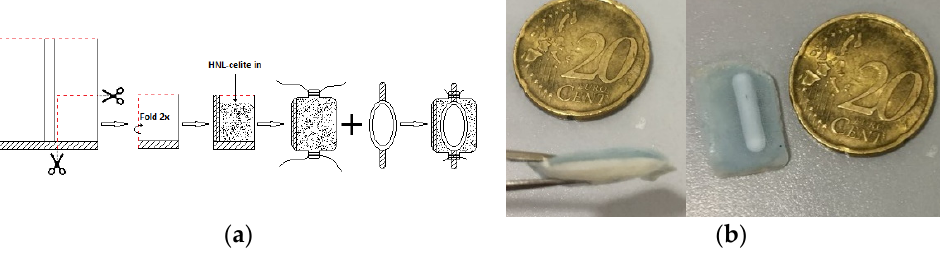
Figure 6. ( a ) the packing of Celite immobilized Pa HNL in a tightly packed bag; ( b ) Loosely packed Celite immobilized Pa HNL; two bags (one with the enzyme, the other with the stirrer bar) are attached to each other.